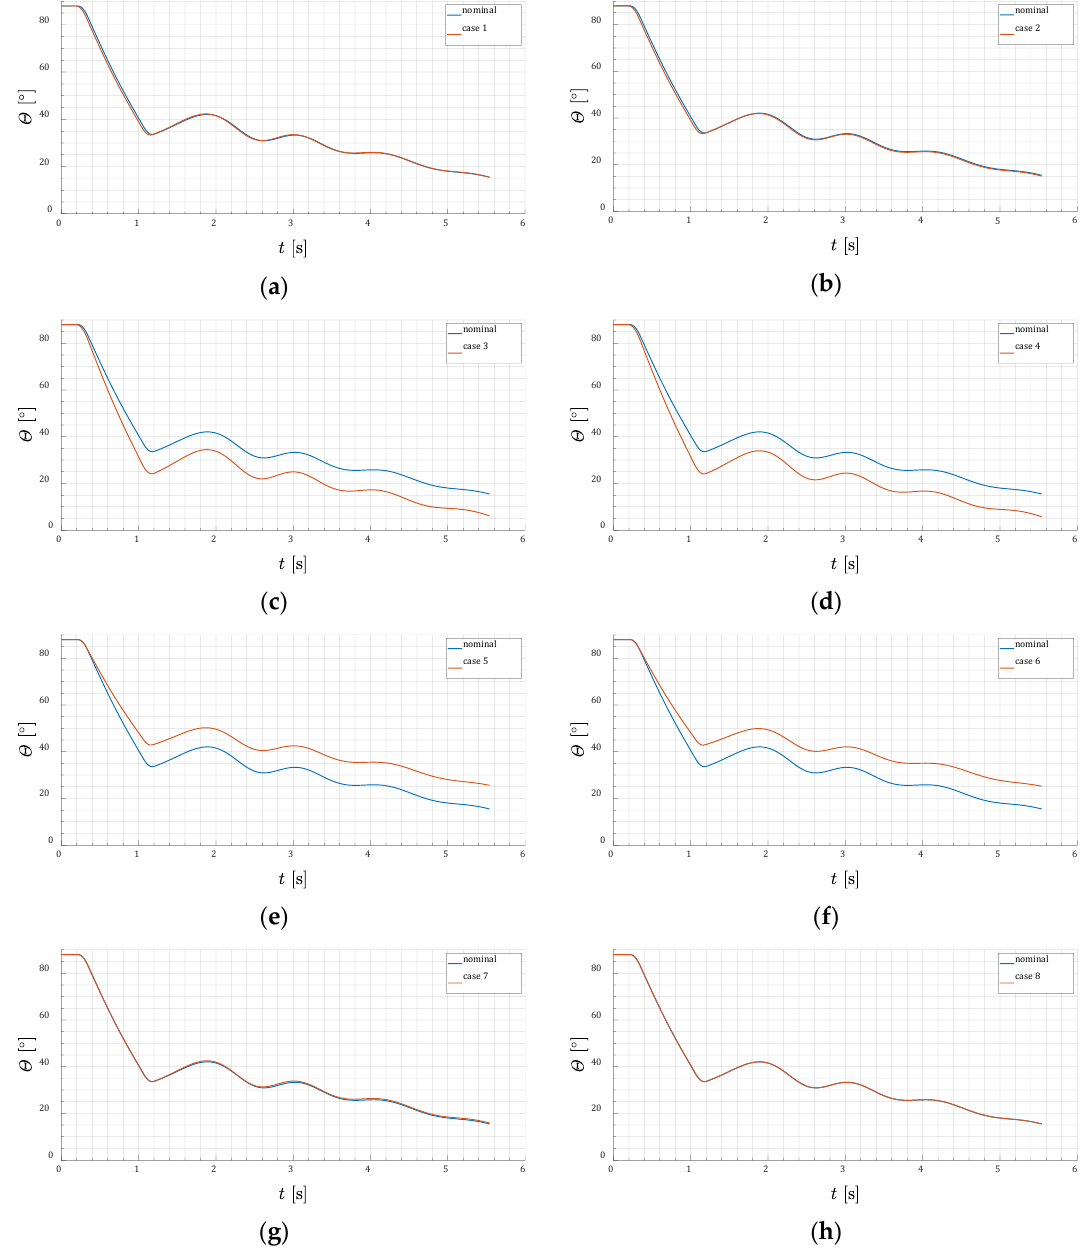
τ τ τ = 0.189, τ delay combinations: ( a ) Figure 15. Projectile pitch angles for various τ 2 , 3 delay combinations: ( a ) 1 , 1 = 0.961; ( c ) τ = 0.189, τ = 0.341, τ = 0.939; ( d ) τ 3 2 3 1 𝜏𝜏 1 , 𝜏𝜏 2 , 𝜏𝜏 3 = 0.319, τ = 0.939; ( f ) τ = 0.211, τ = 0.319, τ 2 3 2 1